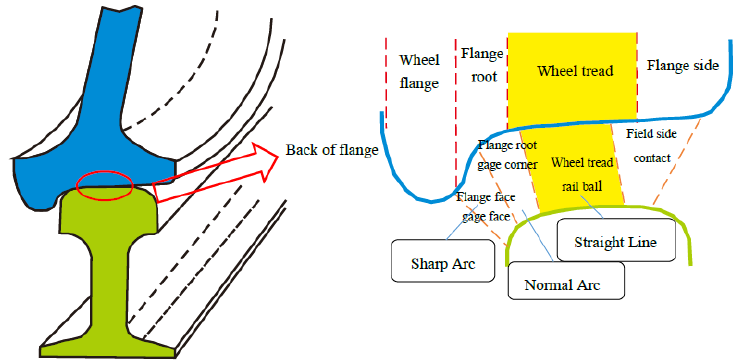
Figure 1. Contact points of the rail and wheel in a variety of paths [4].